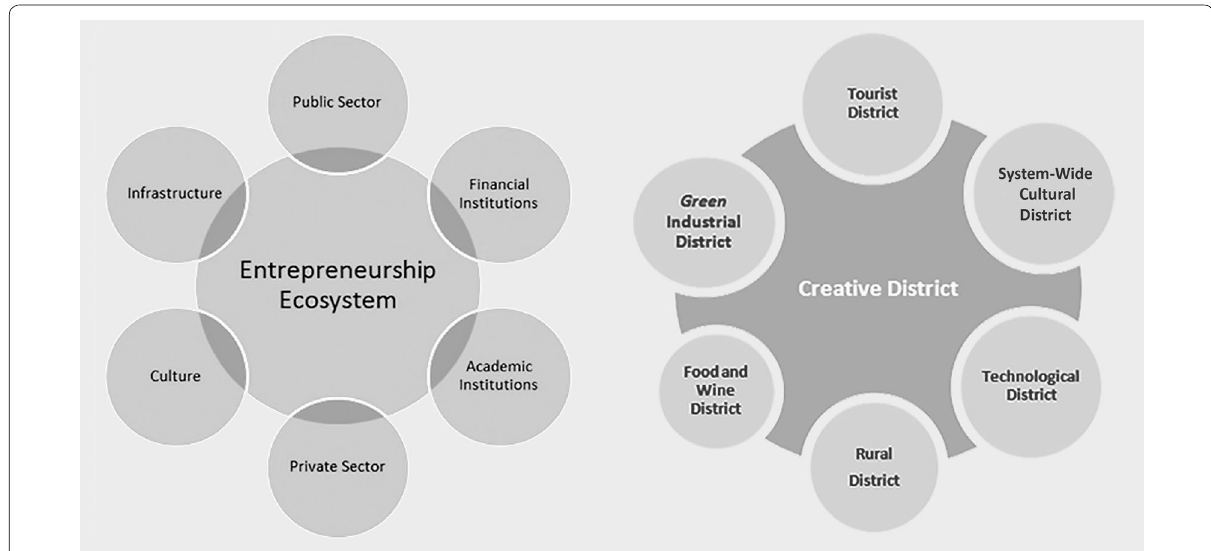
Fig. 1 The ecosystem model applied to SMEs in economic studies on innovation and to cultural/creative ecosystems: the nested geographies of EE and SWCD (Source: elaboration of the authors on Brown and Mason (2017) and Usai